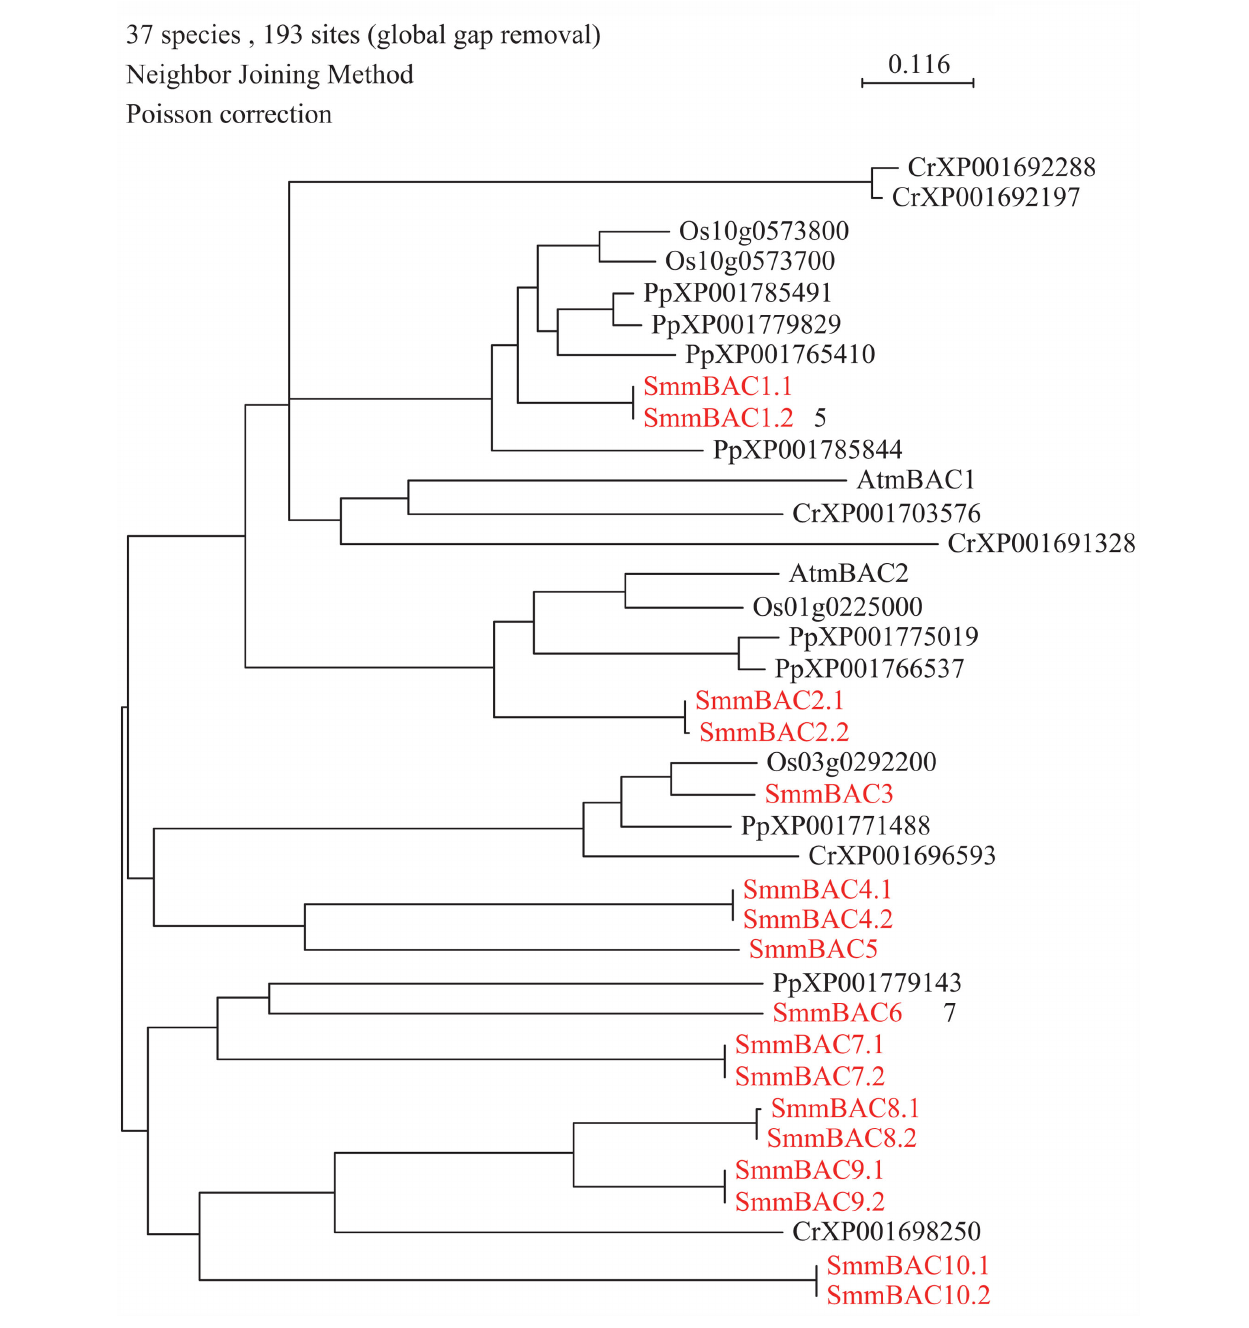
FIGURE 3 | Phylogenetic tree of mitochondrial basic amino acid carriers (mBAC) transporter family. The alignment was obtained from ClustalW and tree was build using PAUP software. At, Arabidopsis thaliana ; Cr,